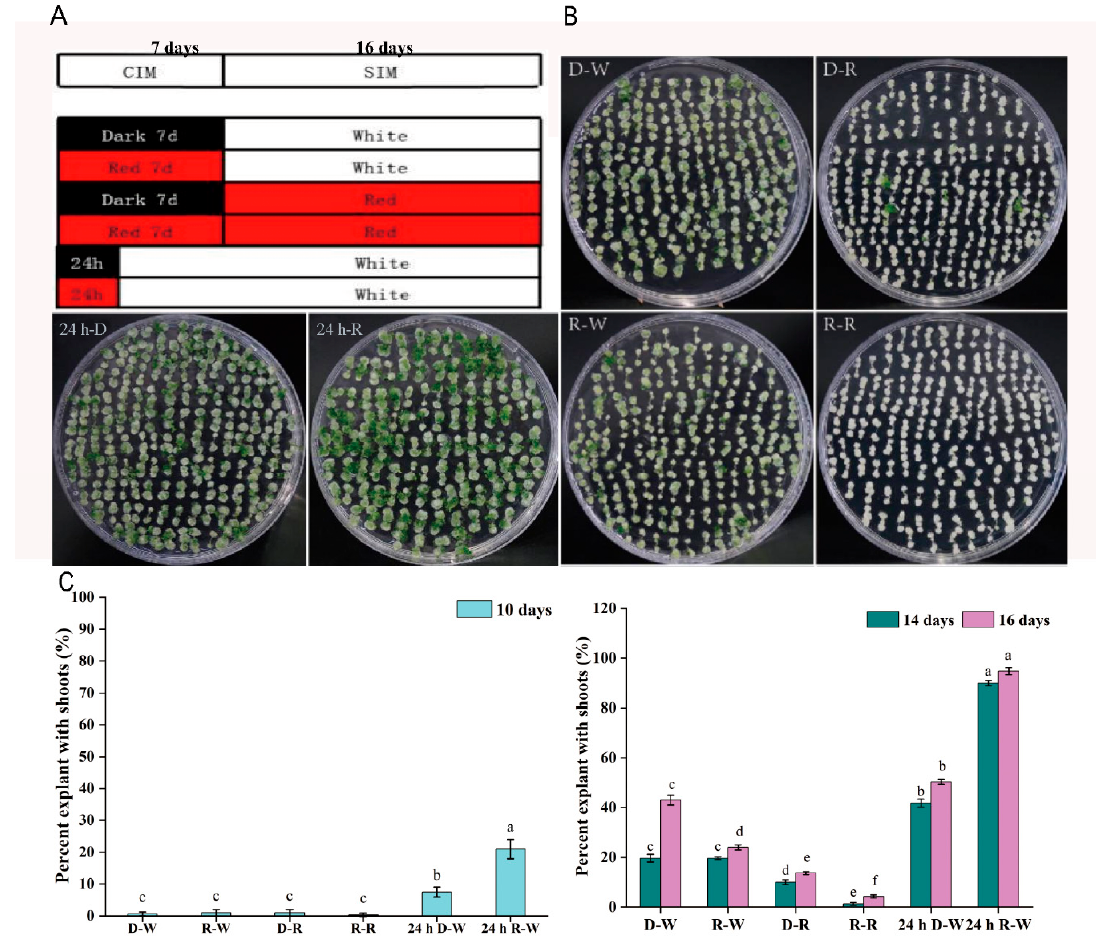
Figure 1. Effects of treatments with combinations of darkness, red, and white light on shoot regeneration in Arabidopsis Col-0 callus. ( A ) Light-combinations used in the callus-induction medium (CIM) and shoot-induction medium (SIM) stages. ( B ) Phenotypes of shoots induced under different light treatments at 16 days on the SIM. ( C ) Percent of explants with shoots at 10, 14, and 16 days on the SIM. D-W (the control treatment), dark in the CIM, white light in the SIM. R-W, red light in the CIM and white light in the SIM. D-R, dark in the CIM and red light in the SIM. R-R, red light in both the CIM and the SIM. 24 h D-W, early 24 h dark and then shifting to 6 days white light in the CIM followed by white light throughout the SIM. 24 h R-W, early 24 h red light shifting to 6 days white light in the CIM, followed by white light treatment in the SIM. The above experiments were performed with three biological replicates, each containing 120 root segments of Arabidopsis thaliana . Standard errors were calculated from three sets of biological replicates. A significant difference in the percent of explants with shoots between different treatments was analyzed at 10 days, 14 days and 16 days, respectively. The least significant difference method (LSD) was used for significance test ( p < 0.05); different lowercase letters represent statistical differences in pairwise comparisons between LSD test groups ( p < 0.05).